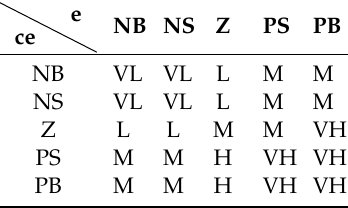
Table 4. Rules for fuzzy—Rule 2.